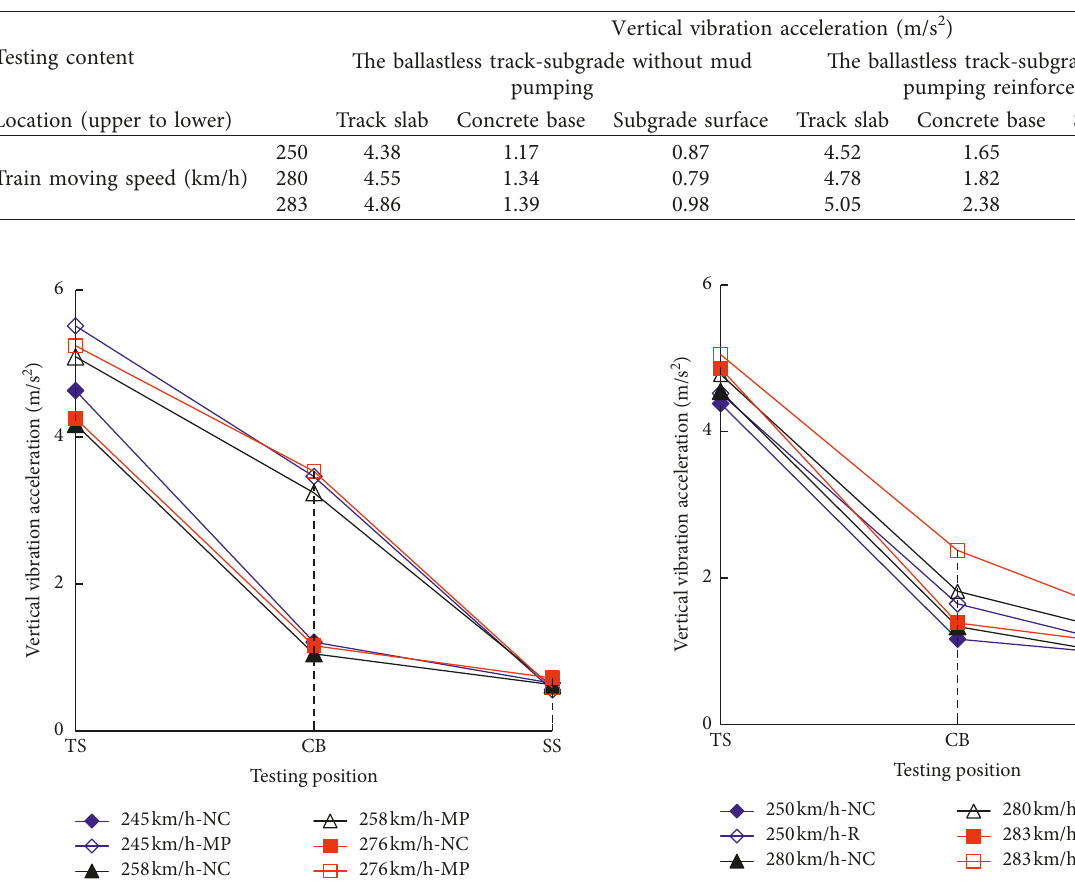
Figure 12: The distributions of the vertical vibration acceleration of the ballastless track-subgrade without mud pumping and after mud pumping reinforcement. R after mud pumping